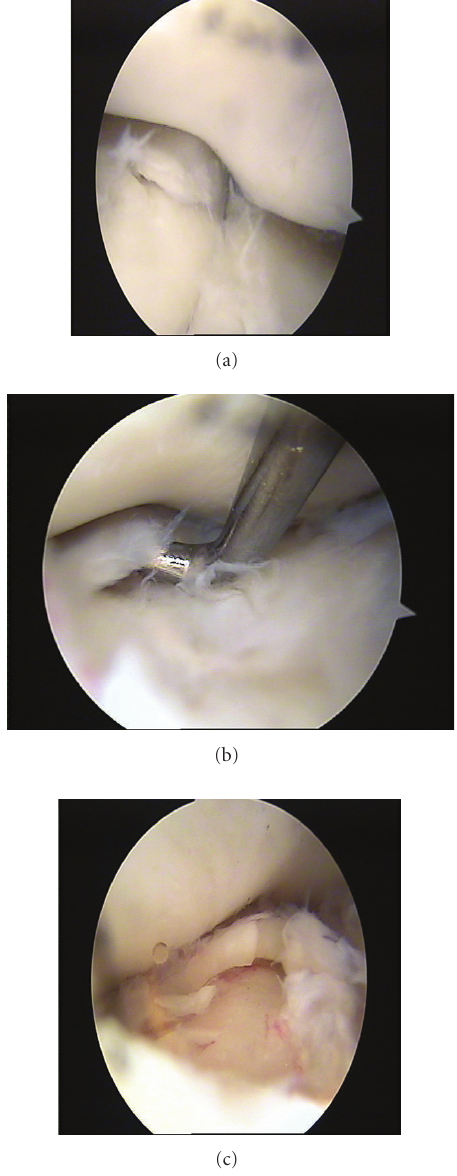
Figure 2: (a)-(b) Photographs showing grade 3 chondral defect on the articular surface of radial head. (c) Photograph showing microfracture following the debridement of the loose cartilage